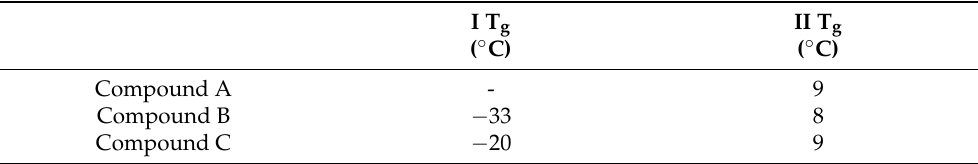
Table 1. Experimentally identified glass transition temperatures for compounds A, B, and C.